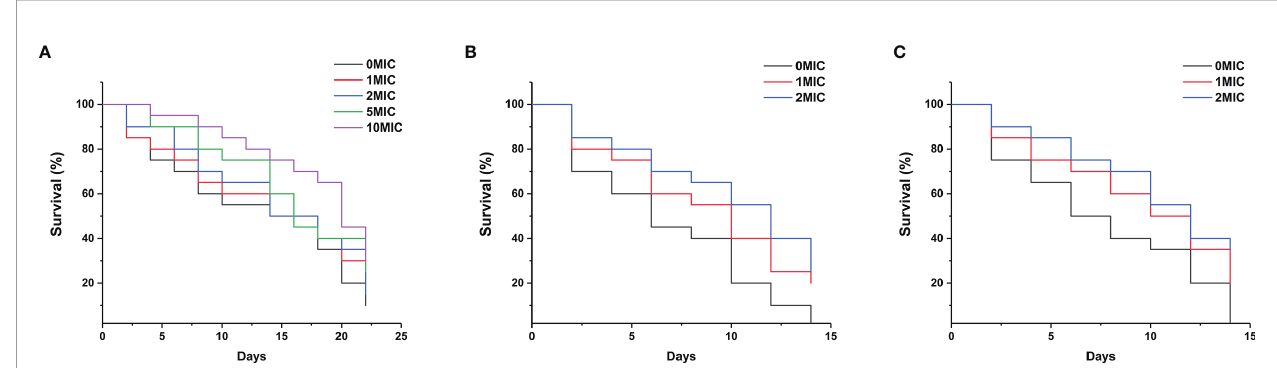
FIGURE 9 | (A) The growth of C. elegans was determined in the presence of high concentrations of paeonol, and the survival rate was monitored in different treatment groups. (B, C) Survival of C. elegans exposed to the pathogenic fungi C. albicans SC5314 (B) and C. neoformans H99 (C) in the presence of different concentrations of paeonol. The survival rate of C. elegans was evaluated in the various treatment groups. The values refer to the mean survival rate of three biological